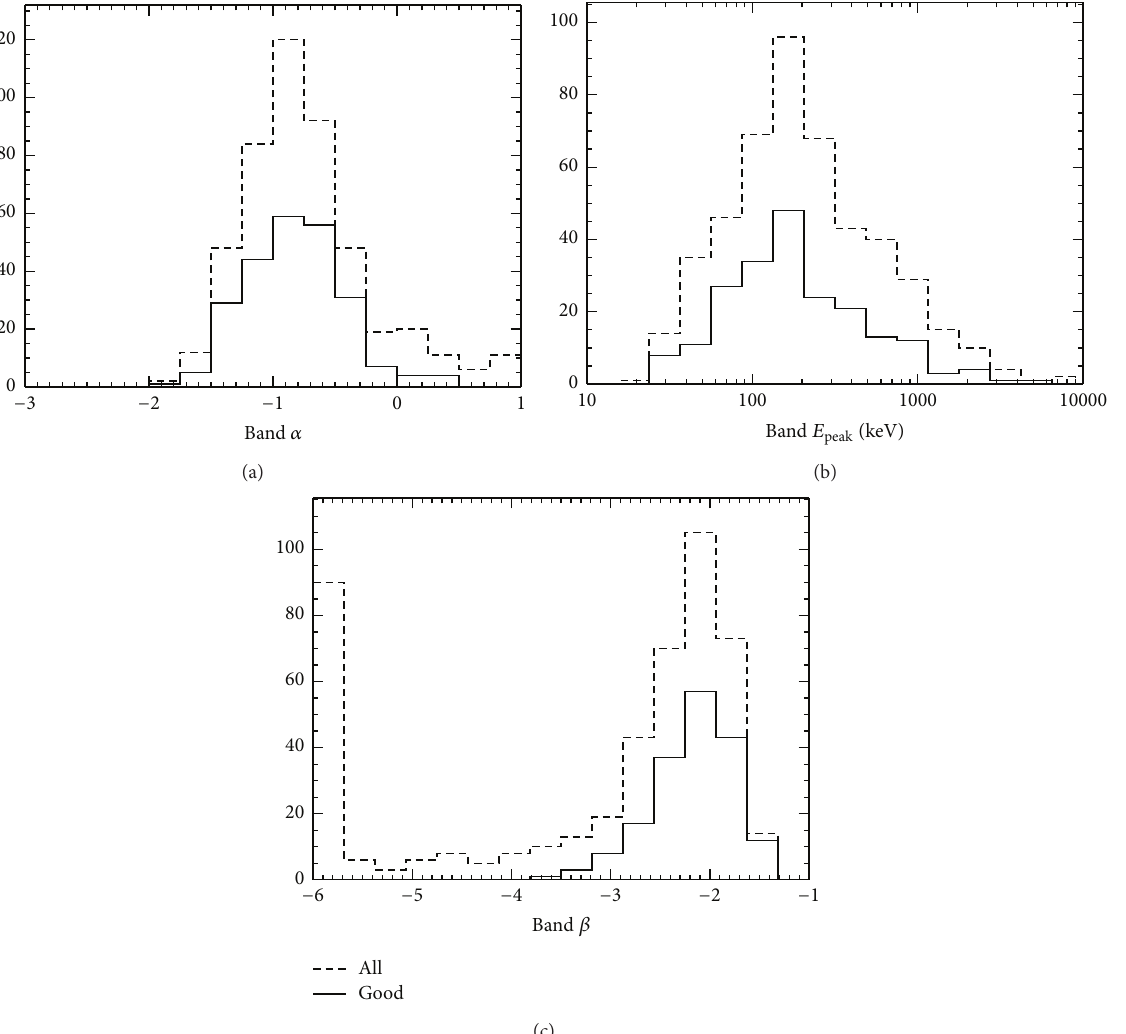
Figure 5: Histograms of the distributions of “Band” model free parameters: the low energy slope 𝛼 (a), peak energy 𝐸 peak (b), and the high energy slope, 𝛽 (c). The data represent 3800 spectra derived from 487 GRBs in the first FERMI -GBM catalogue. The difference between solid and dashed curves is the goodness of fits, the solid curve represent fits which were done under minimum 𝜒 2 criteria, and the dash curves are for all GRBs in the catalogue. Figure adopted from Goldstein et al.